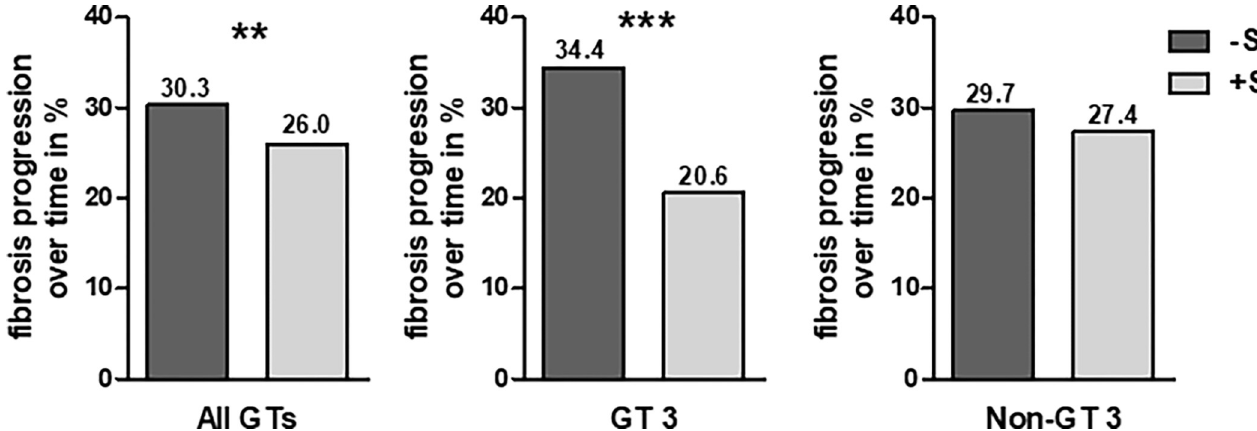
Fig 1. Rate of fibrosis progression over time in % for patients with steatosis (+S) at baseline and without steatosis (-S) at baseline. �� = p < 0.01, ��� = p < 0.001.